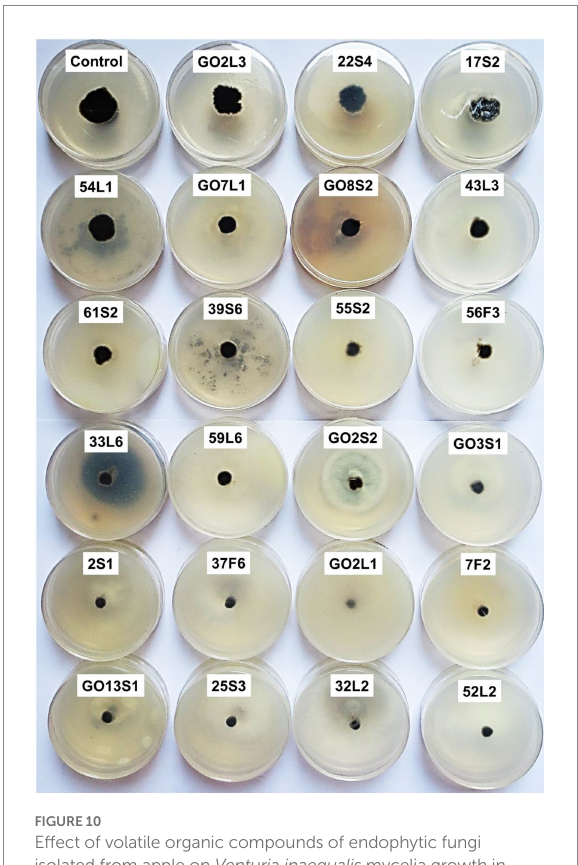
FIGURE 10 Effect of volatile organic compounds of endophytic fungi isolated from apple on Venturia inaequalis mycelia growth in comparison to control after 1 month in vitro .